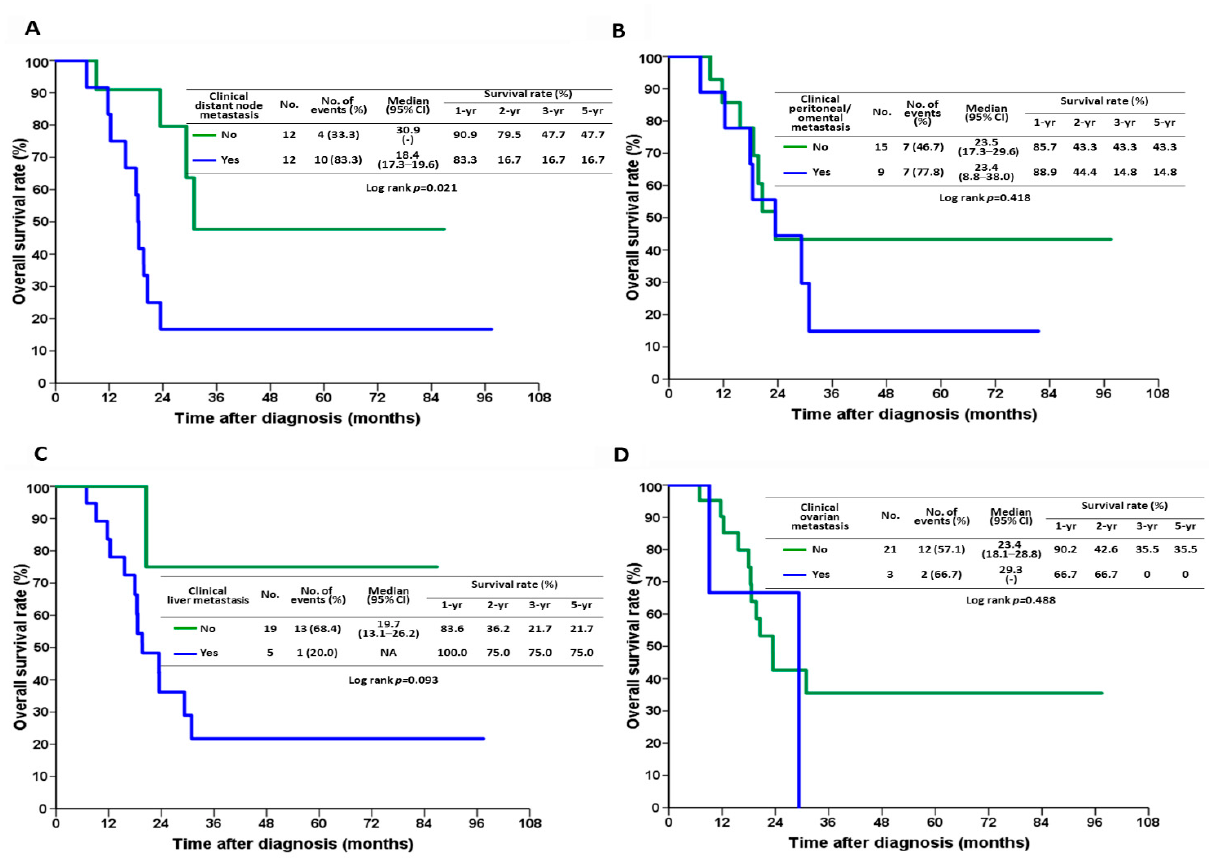
Figure 4. Kaplan–Meier survival curves after the initial diagnosis in the conversion surgery group in terms of ( A ) distant node metastasis, ( B ) peritoneal/omental metastasis, ( C ) liver metastasis, and ( D ) ovarian metastasis.